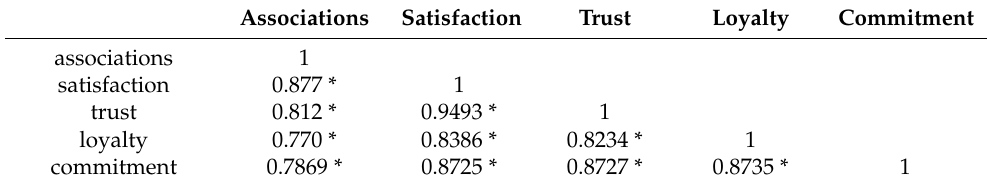
Table 1. The correlation matrix between associations ≥ satisfaction ≥ trust ≥ commitment ≥ loyalty. Associations Satisfaction Trust Loyalty